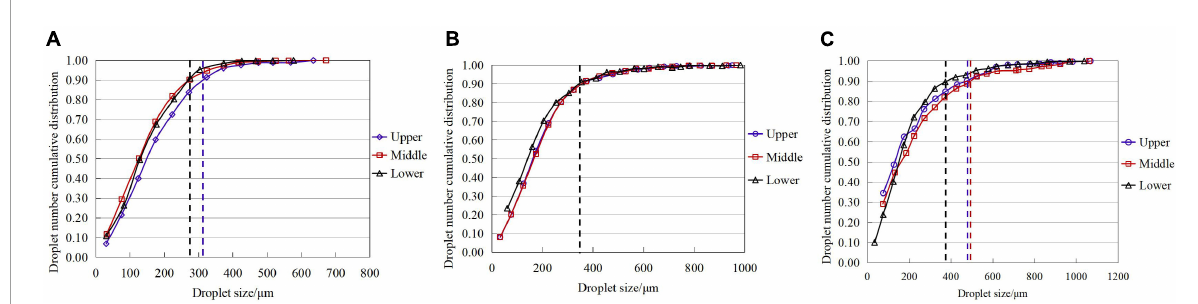
FIGURE7 Cumulative ratio of droplet number and the corresponding droplet size at various canopy layers under different flight velocity. The vertical dotted lines represent the VMD when the cumulative proportion of droplet points reaches 0.9, where the blue, red, and black dotted lines represent the upper, middle, and lower layer of the canopy, respectively. (A) 1 m/s. (B) 2 m/s. (C) 3